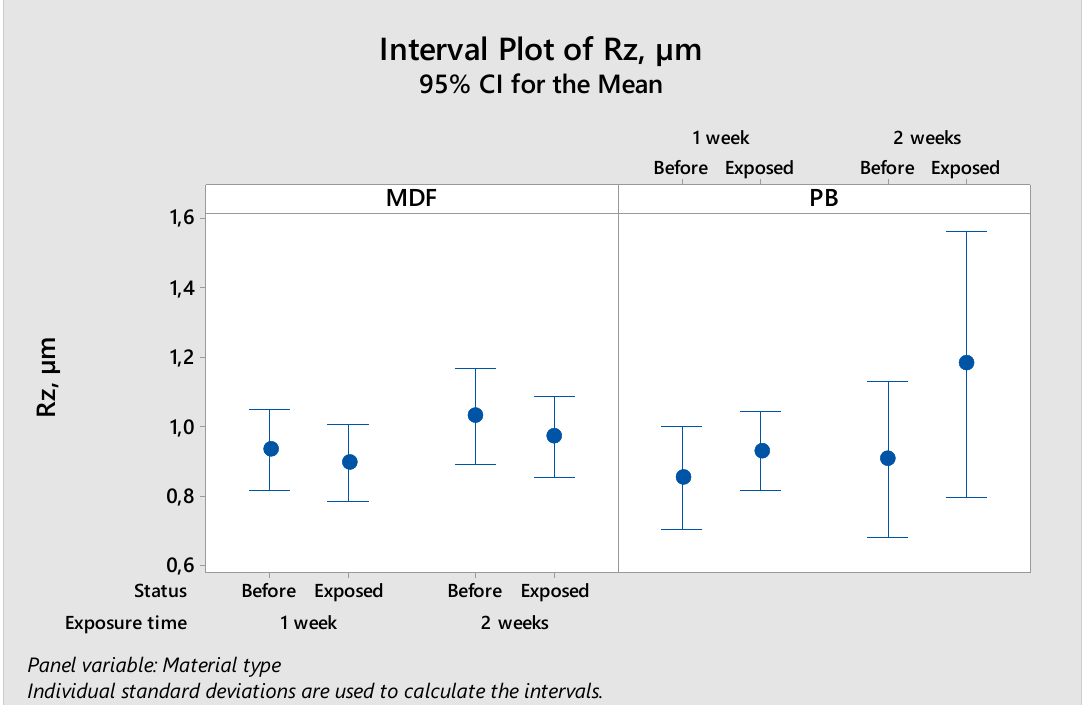
Individual standard deviations are used to calculate the intervals. Figure 5. Variation of the average roughness parameter ( Ra ) of the overlaid MDF and PB samples, before and after exposure to humidity conditions. Coatings 2019 , 9 , x FOR PEER REVIEW